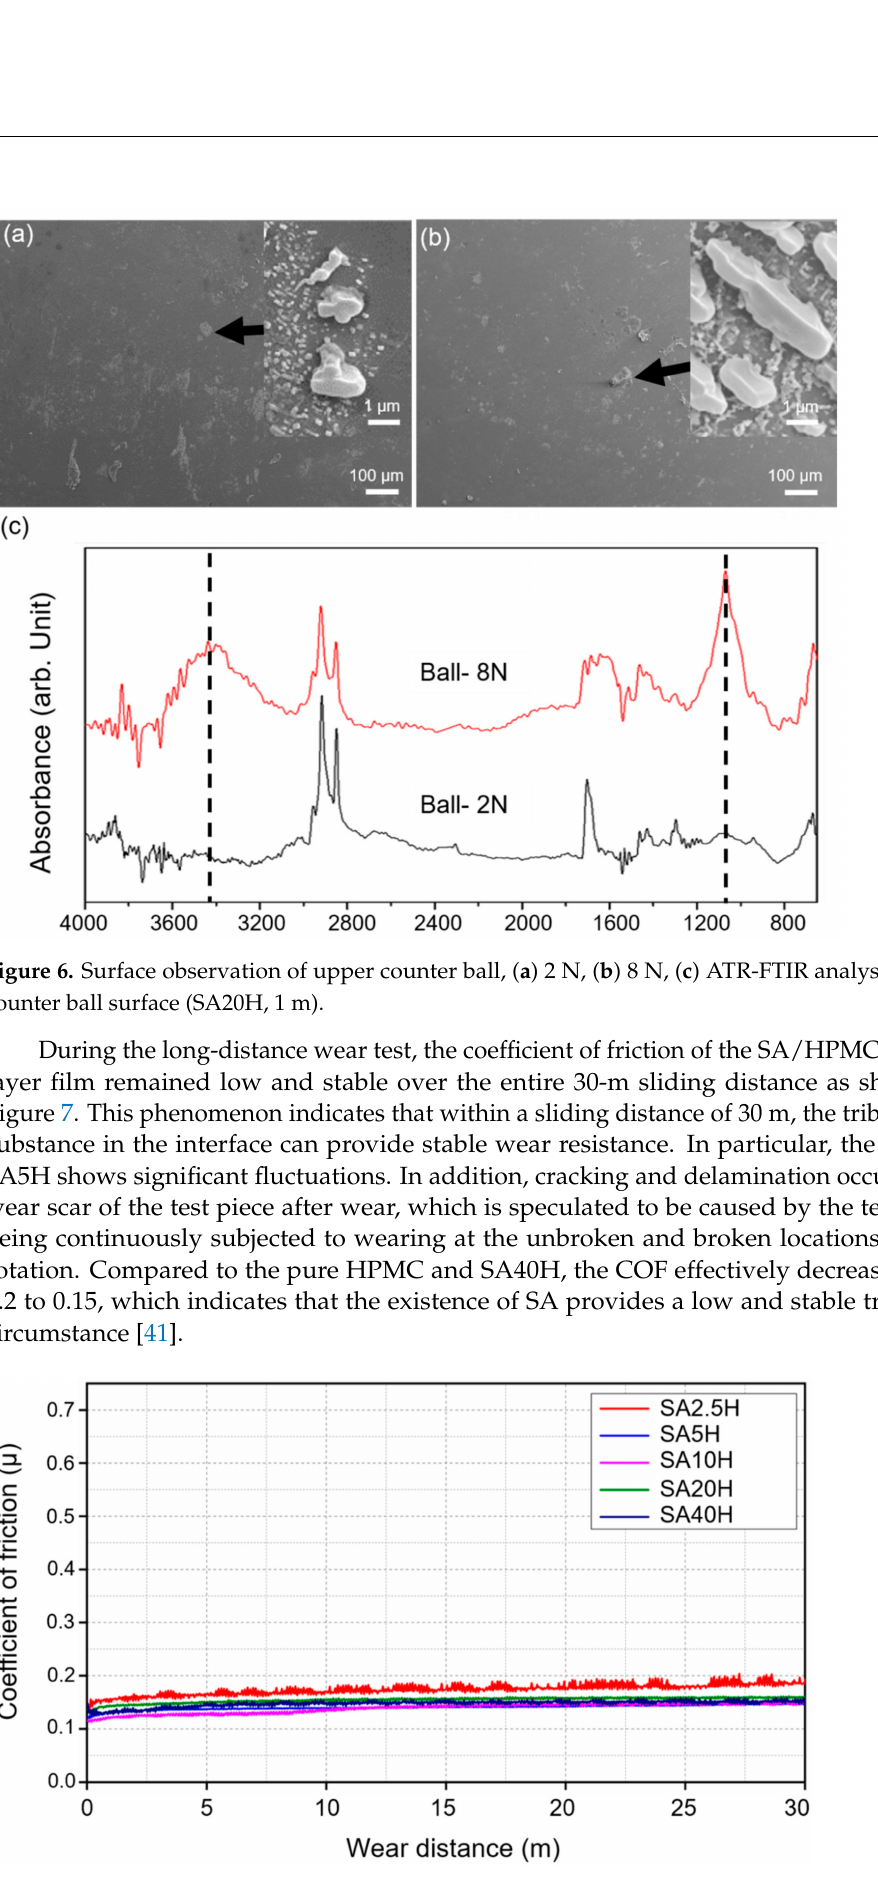
Figure 7. Coefficients of friction for coatings under long-distance wear (SA20H, 30